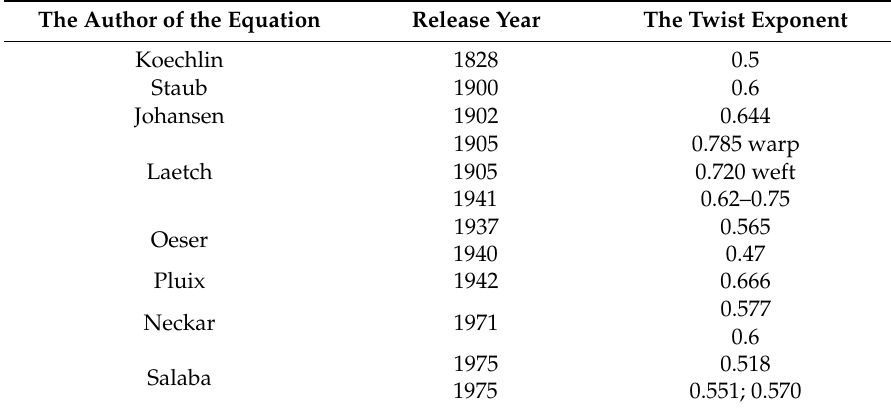
Table 1. Developing equations for calculating the number of turns per meter of yarn ([2], p. 28).